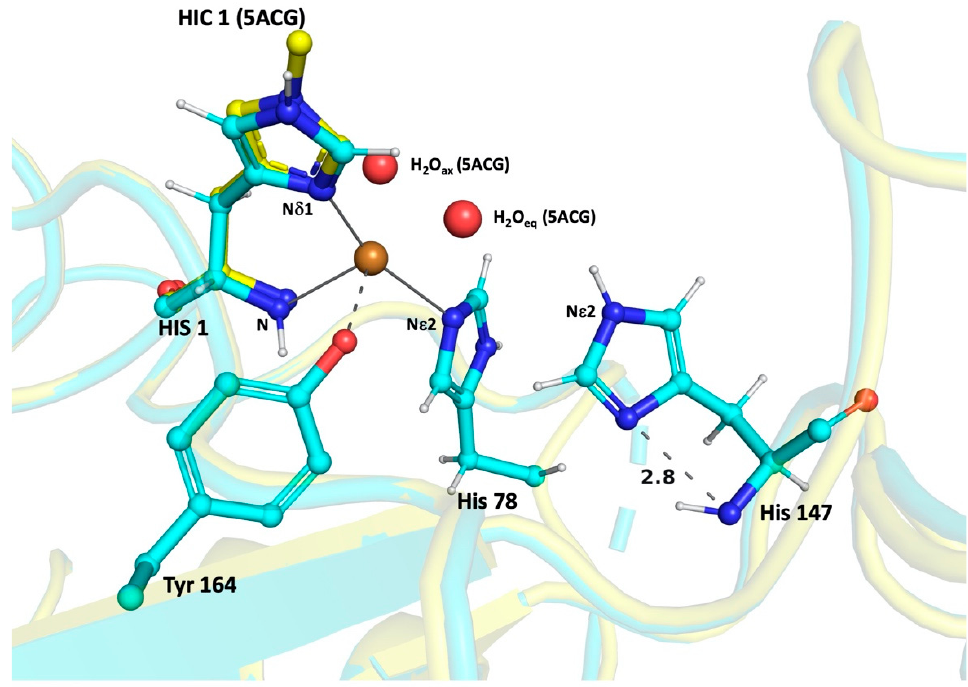
Figure 4. Results from His-only unrestrained refinement in Ls AA9A Ec _2 structure (cyan colored). His147 shows single protonation N ε 2 atom. The Nis-brace residues (internal control) show their single protonation state. The H-bond distance between the N δ 1 and backbone N atoms of His147 is shown in Å. The structure of Ls AA9A_ Ao (PDB id: 5ACG, yellow colored) is shown for comparison with 1 st His methylated (HIC) and the two water molecules bound to the Cu(II). The oxygen species binds at the position of H 2 O eq . The figure was prepared with Pymol.